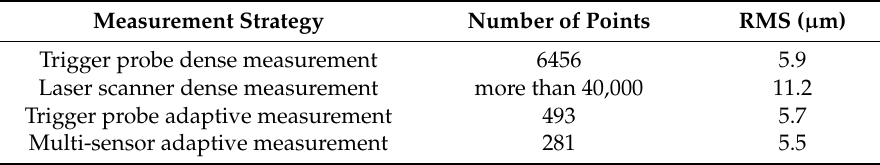
Figure 4. Measurement of a designed complex surfaces on multi-sensor instrument. ( a ) machined workpiece; ( b ) Benchmarking form error; ( c ) multi-sensor fused form error. Table 3. A summary of the actual measurement result.